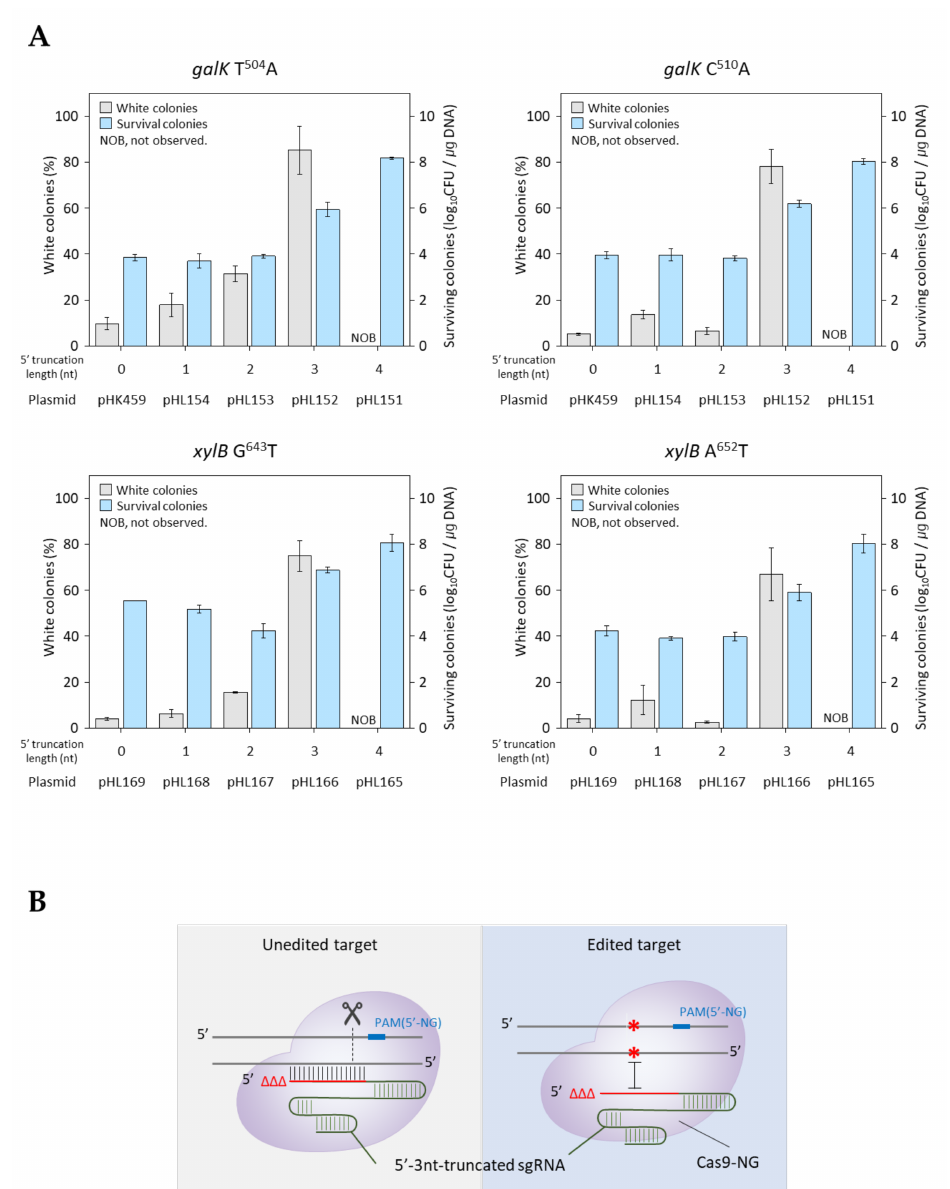
Figure 4. Efficiency of single-base editing with truncated sgRNA/Cas9-NG-mediated negative selection. ( A ) Editing efficiency of the galK and xylB mutation using 5 (cid:48) -untruncated, 1 nucleotide-, 2 nucleotide-, and 3 nucleotide-truncated sgRNAs. ( B ) 5 (cid:48) -truncation of three nucleotides in the sgRNA is optimum for Cas9-NG-mediated negative selection of single- base edited targets in the microbial genome. Each bar represents the standard deviation of three independent